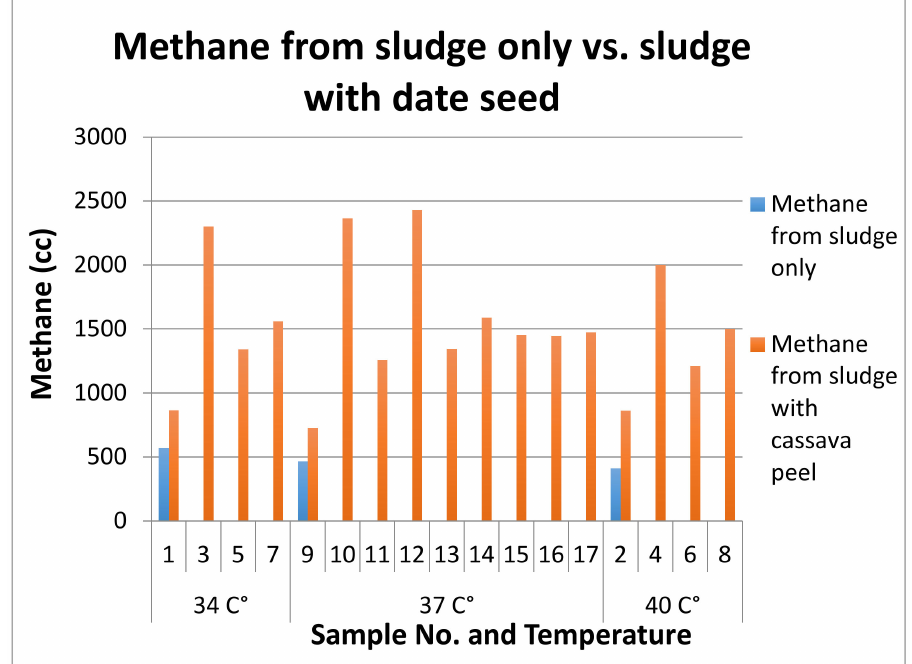
Figure 5. The changing in methane quantity following to add date seed to the sludge. However, the highest amount of Biogas per g-VS of 1838.9 cc/g-VS was obtained at 37 ◦ C, volatile solid value of 1.1 g-VS and at 50% sludge (run #13). At these conditions the highest CH 4 /g-VS quantity of 1143.8 cc/g-VS was recorded. On the other hand, the lowest value of Biogas/g-VS from of 749.5 cc/g-VS was reported at 34 ◦ C, 2.65 g-VS and 25% of the sludge (run #12). The minimum CH 4 /g-VS of 456.4 cc/g-VS was obtained from run #17 at 40 ◦ C, 2.65 g-VS and 25%